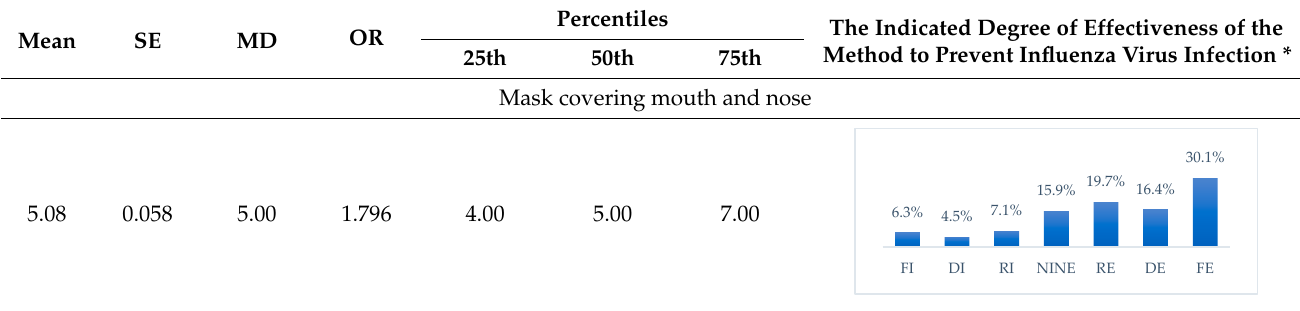
Table 2. Evaluation of the effectiveness of methods to prevent influenza infections ( N = 950).